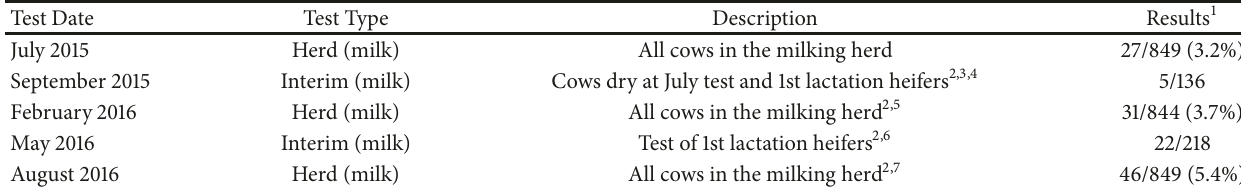
Table 2: Bovine leukemia virus (BLV) antibody testing schedule and results for Herd R.